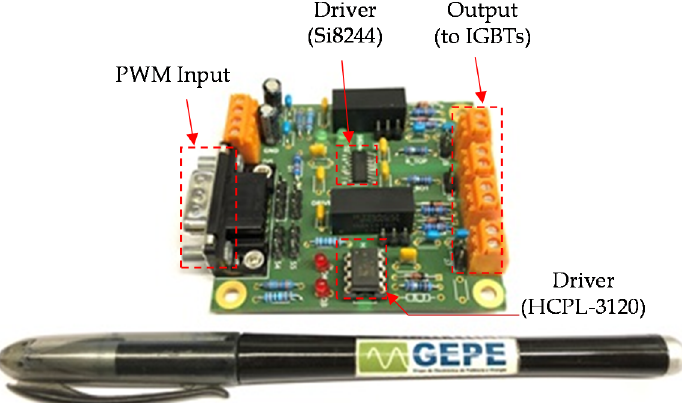
Figure 8. Isolated gate bipolar transistor (IGBT) driver circuit board.